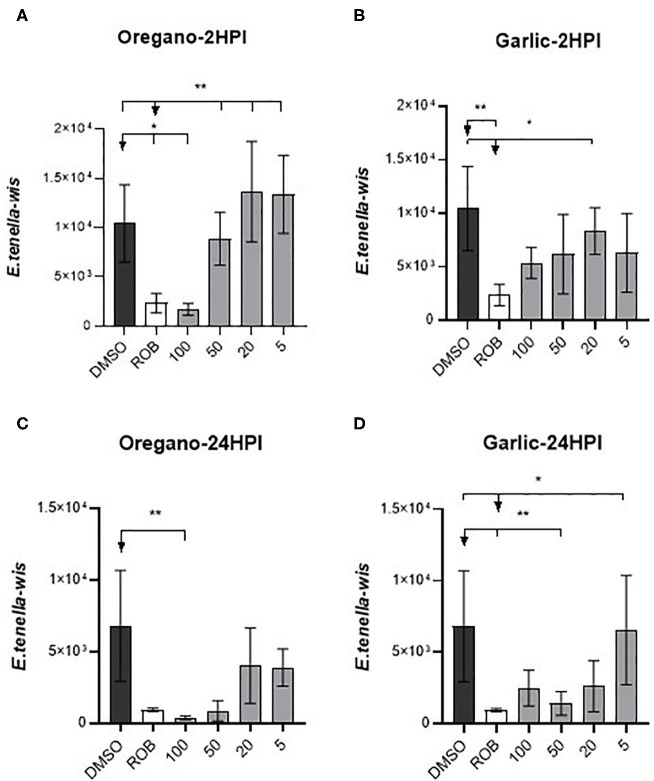
Effect of essential oils on E. tenella infection of MDBK. Intracellular number of parasites: (A) 2 HPI after pre-treatment with oregano essential oil; (B) 2 HPI after treatment with garlic essential oil; (C) 24 HPI after treatment with oregano essential oil; (D) 24 HPI after treatment with garlic essential oil. X-axis numbers represent the dilution in μg/ml used. DMSO, dimethyl sulfoxide (10 μl/ml); ROB, robenidine (5 μg/ml). Asterisks indicate the significance among groups (Dunnett's multiple comparisons test, p < 0.05), whereas *groups compared with ROB and **groups compared with DMSO.